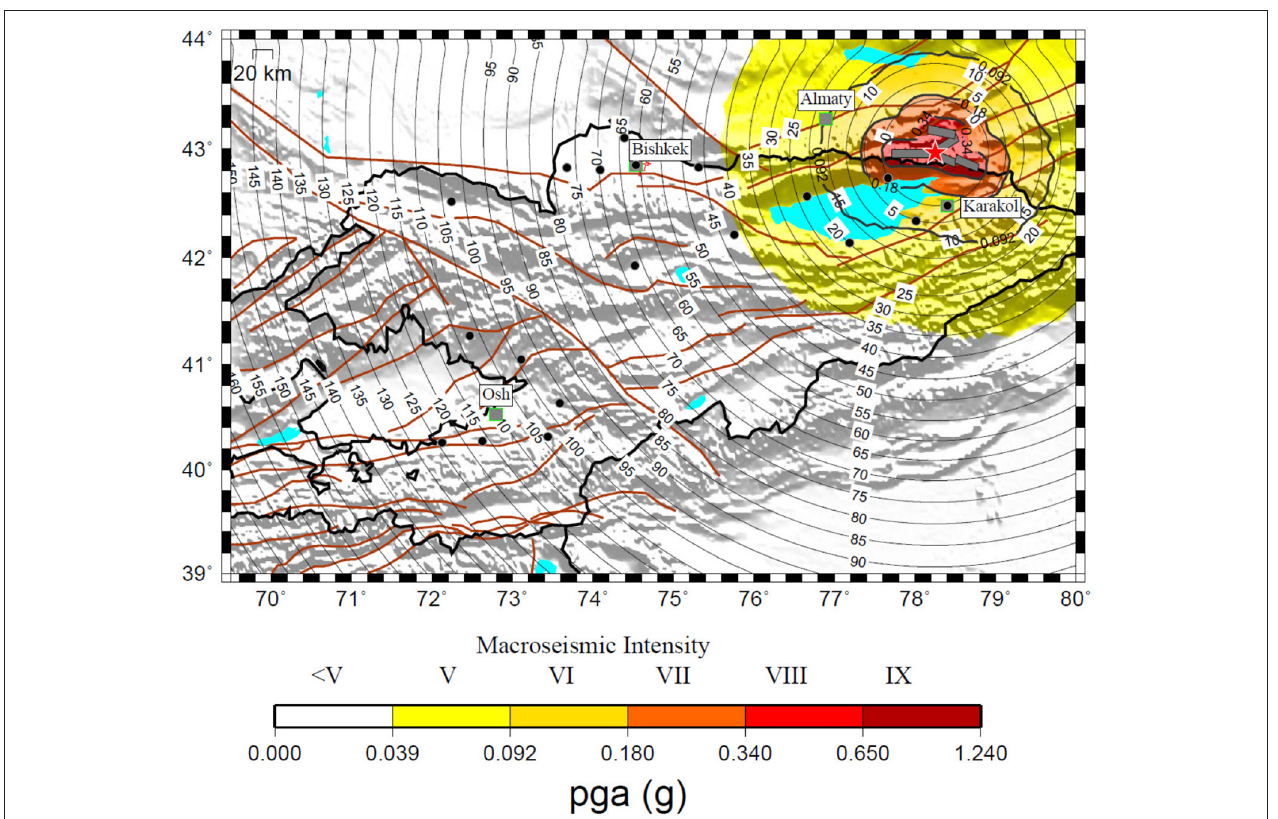
FIGURE 12 | As in Figure 11 but for the M 8-8.3 1889 Chilik earthquake (red